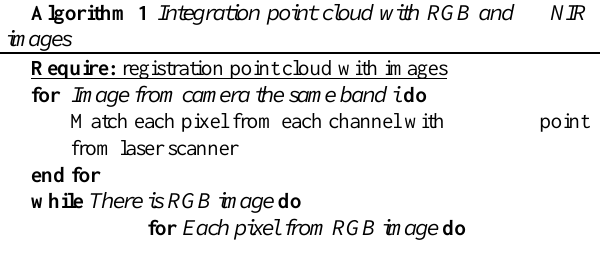
Figure 10: The idea of the integration of the point clouds and images Algorithm 1 Integration point cloud with RGB